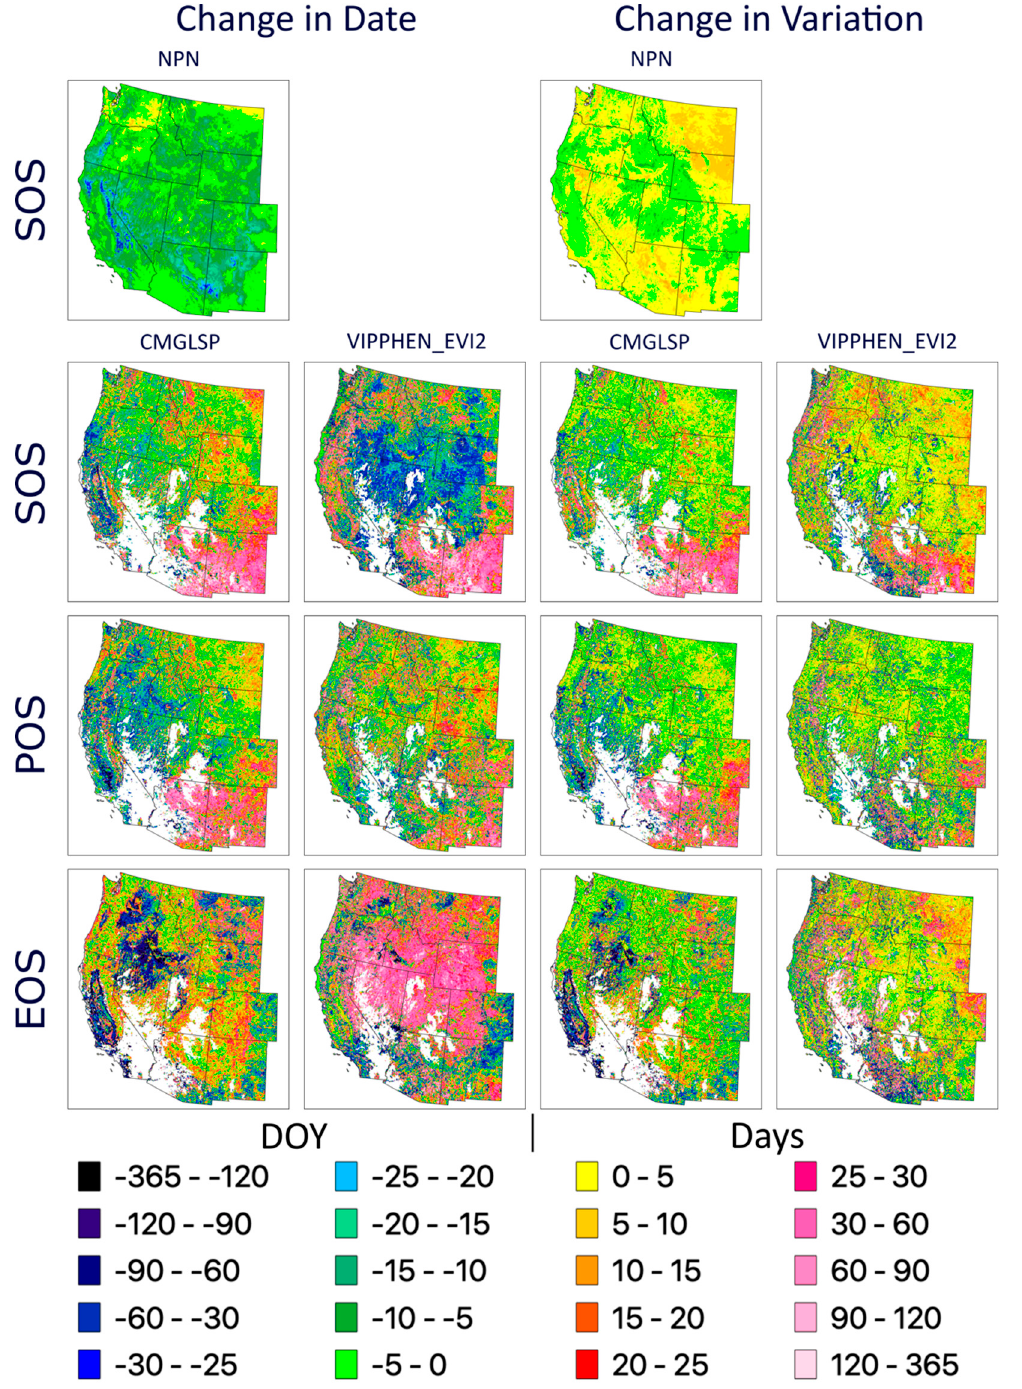
Figure A4. Change in date and variation of CMGLSP, VIPPHEN_EVI2, and NPN across three phenology metrics (only SOS for NPN) from 1982 to 2016. Shown here with a more robust color scheme to better indicate change. Negative values correspond to earlier dates (or fewer days) and positive values to later dates (or more days). Change in date is the regressed trend slope multiplied by the number of years. Change in variation is the regressed trend slope of the absolute value of the residuals multiplied by the number of years.